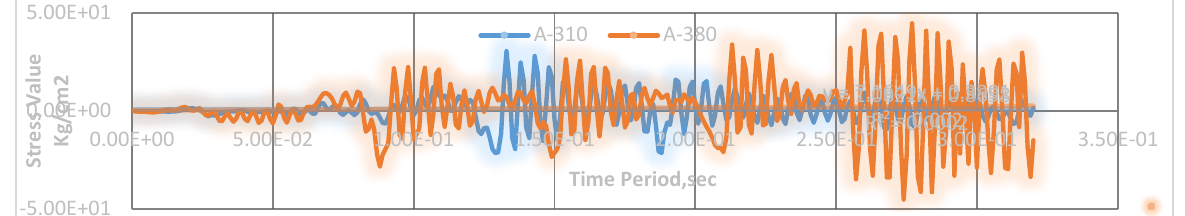
Fig. 9. Stress-Time History Curve for Speed =160 kmph, h=20cm, E=40000MPa.